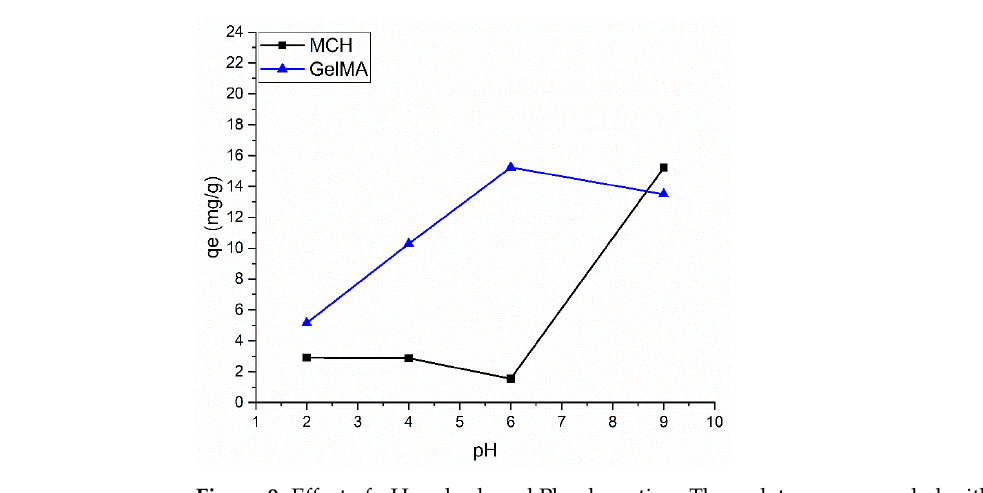
Figure 9. Effect of pH on hydrogel Pb adsorption. Those data were recorded with 30 mg/L Pb initial concentration.